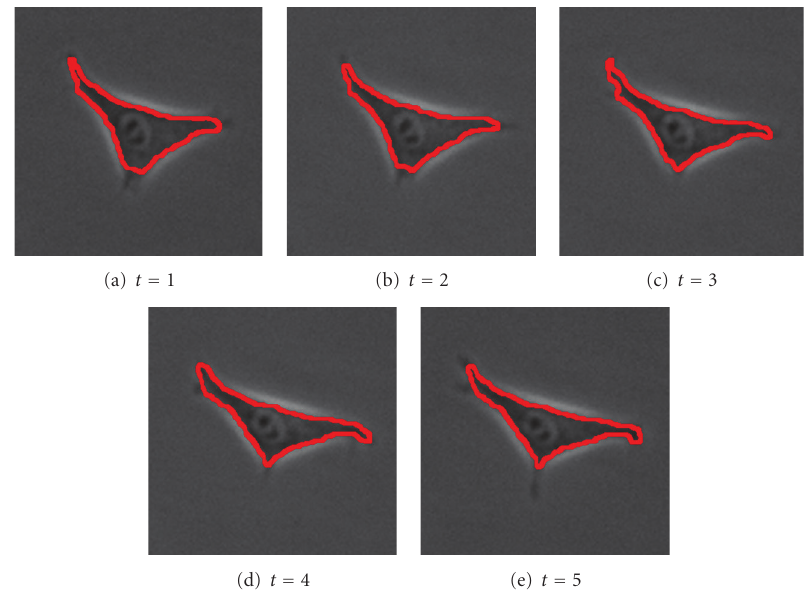
Figure 17: 2 segments found with parameters ( n , α , (cid:7) α , β , θ , γ , d 1 , σ , ρ ) = (121,11,30,10,0 . 025,0 . 01,0 . 15,7,3).